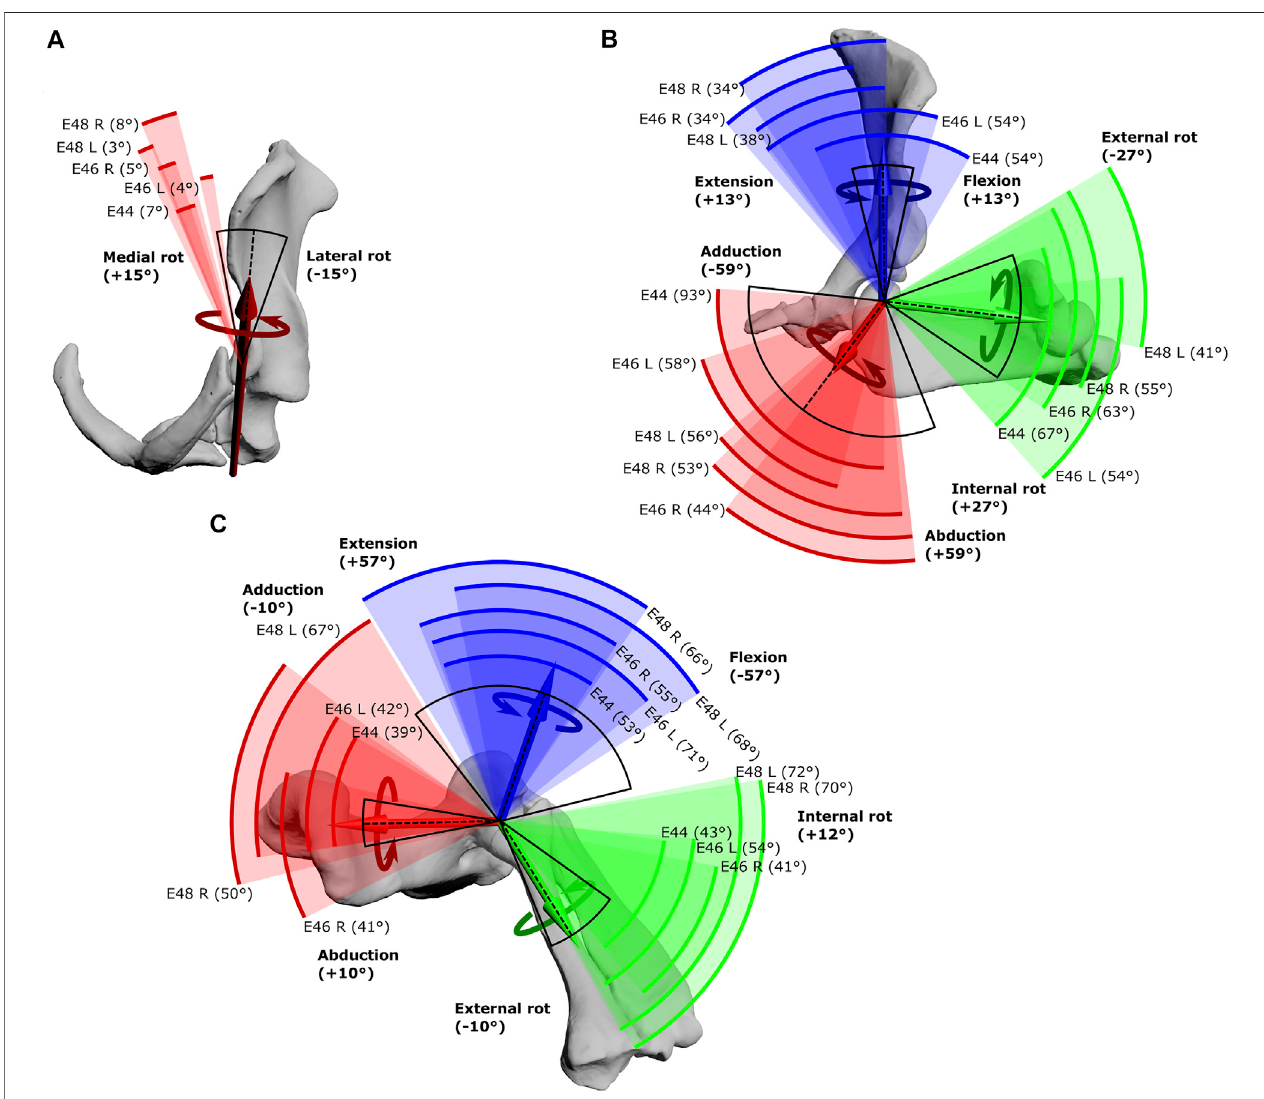
FIGURE 3 | Maximal Range of Motion (ROM) at the echidna forelimb joints. (A) scapulocoracoid-clavicle-interclavicle joint, (B) glenohumeral joint, (C) humeroradioulnar joint. Experimentally-estimated ROMs (pooled raw data) for each echidna specimen E44, E46 and E48 (coloured arcs, total ROM in parentheses) compared with initial model-predicted ROMs based on single DOF rotations (black arc, limits in bold text) about the X (red), Y (green) and Z (blue) axes. The dotted line represents the limb ’ s reference position. See Table 1 for more details.